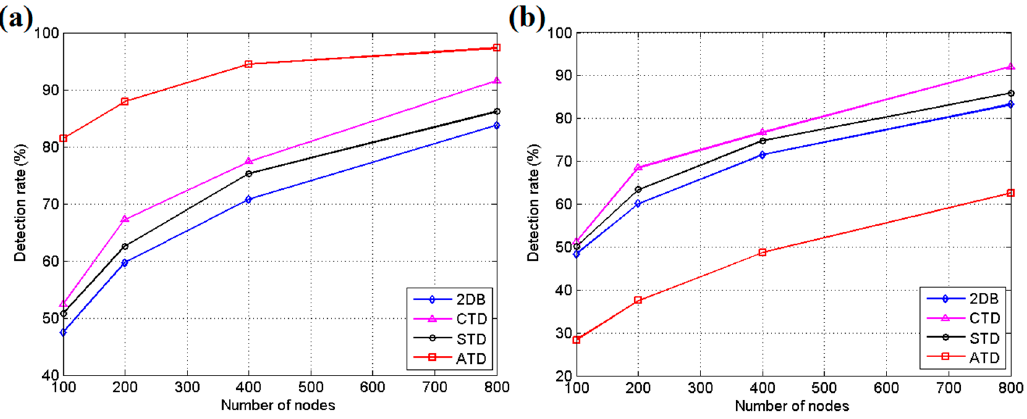
Figure 8. ( a ) Average detection rate for directional intrusion; and ( b ) average detection rate for random intrusion.